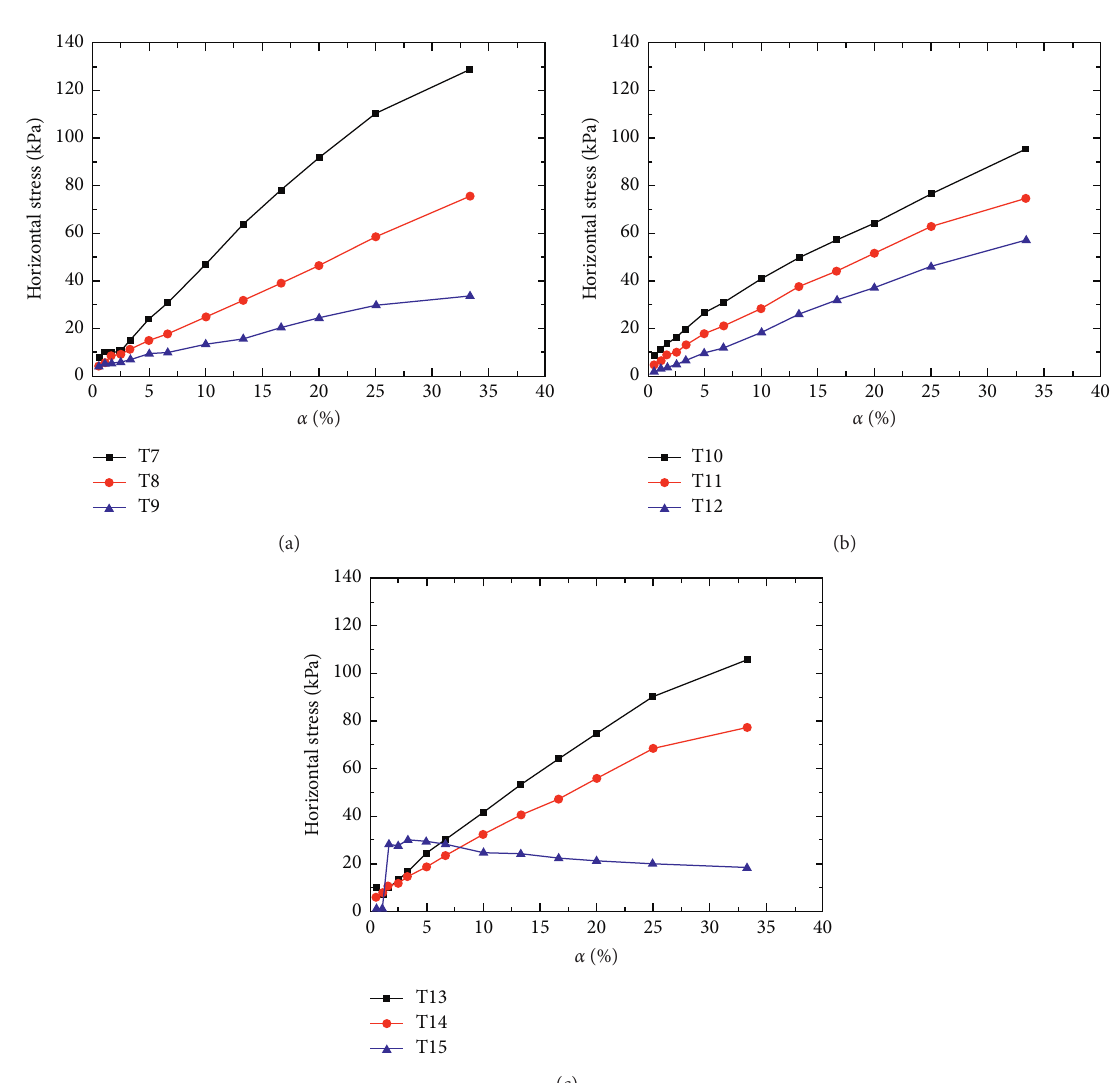
Figure 15: Horizontal stress of soil. (a) Depth of 0.9m. (b) Depth of 0.6m. (c) Depth of 0.3